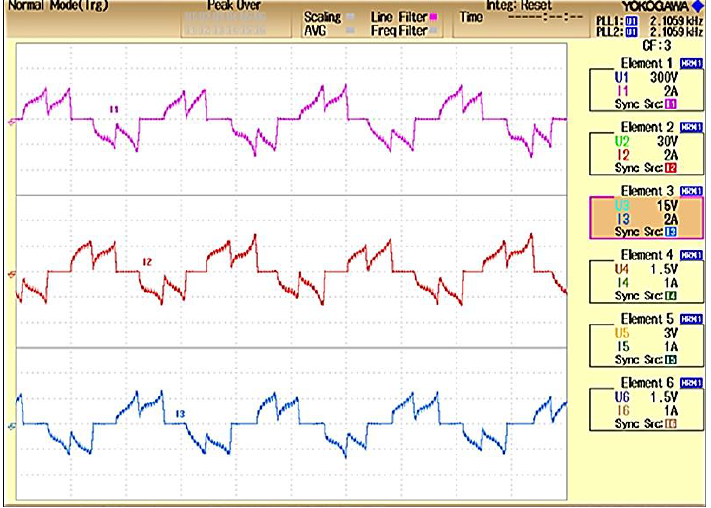
Figure 20. Voltage source inverter-fed BLDC motor output current waveform.